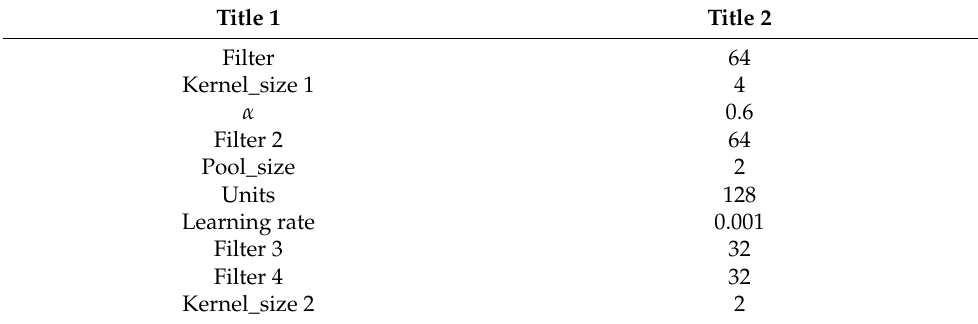
Table 2. Partial parameter setting for the abnormal data detection